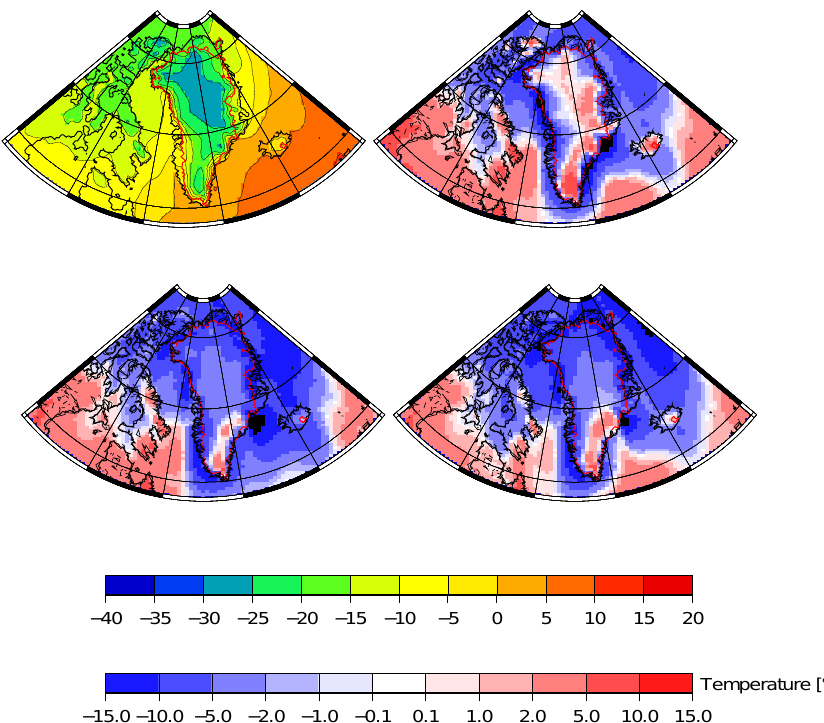
Figure 14. Difference in mean annual temperature between the climatology and the different experiments: CTRL (b) , SNOW (c) , PRE- CIP (d) . The reference climatology is shown in (a)